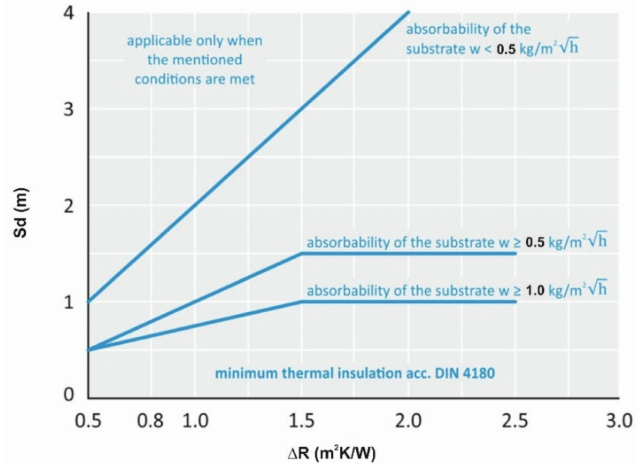
Figure 2. Minimal requirements for the thermal insulation layer depending on the thermal resistance of the insulation for bases displaying di ff erent capillary activity